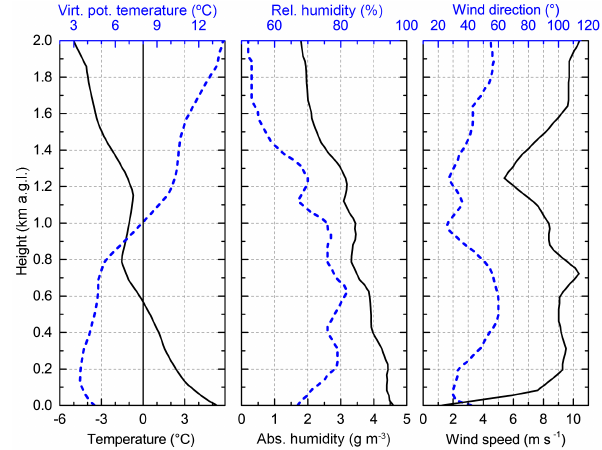
Figure 4. Profiles of temperature, virtual potential temperature, ab- solute and relative humidity, horizontal wind speed, and wind di- rection measured with the radiosonde on IOP 5 on 20 April 2013 at 07:00UTC.